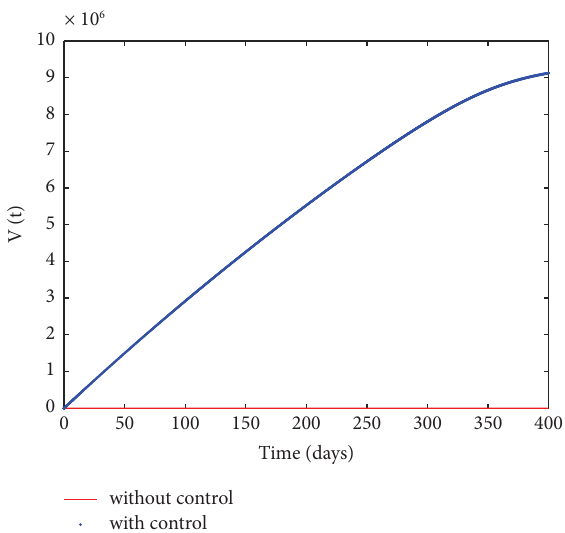
Figure 22: Behaviour of the immune individuals with and without the vaccination